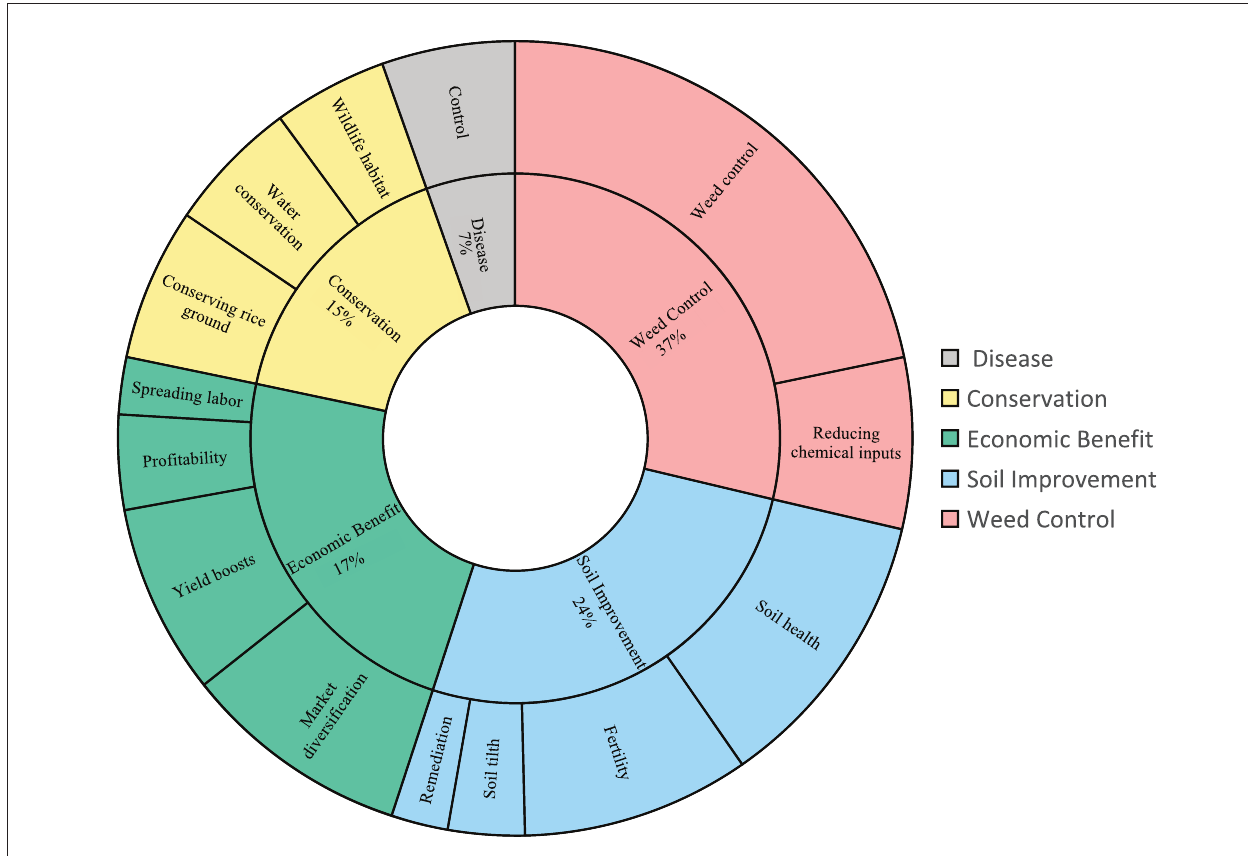
FIGURE 2 | Perceived benefits of crop rotations in rice systems. The inner circle represents the major theme or benefit discovered through our qualitative analysis. The size of the inner circle is based on the number of references coded under each theme. The outer circle represents the different ways growers talked about the major themes. The relative size of each category corresponds with the number of times that category was